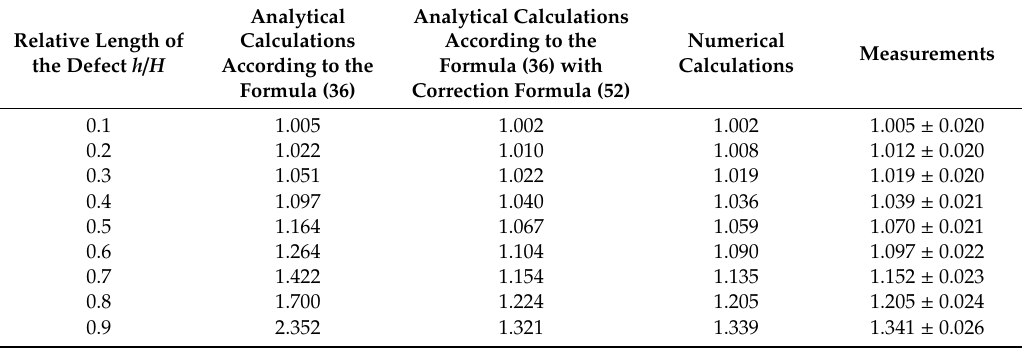
Table 1. The comparison of calculation results according to di ff erent models and measurements of the relative resistance R / R 0 of the layer with a defect depending on the relative length of the defect h / H. Analytical Calculations Analytical Numerical According to the Calculations Relative Length of Formula (36) with According to the the Defect h / H Formula (36) Correction Formula (52)